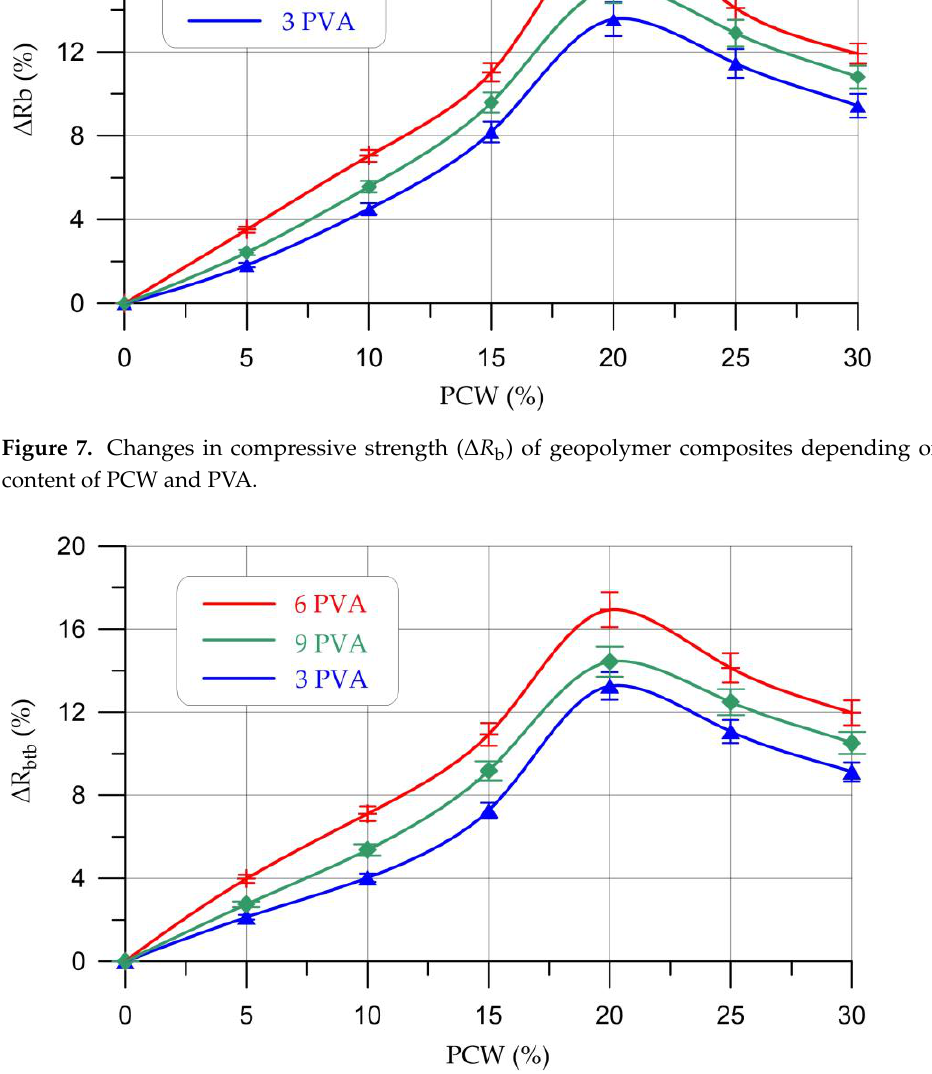
Figure 7. Changes in compressive strength (∆ R b ) of geopolymer composites depending on the con- tent of PCW and PVA.